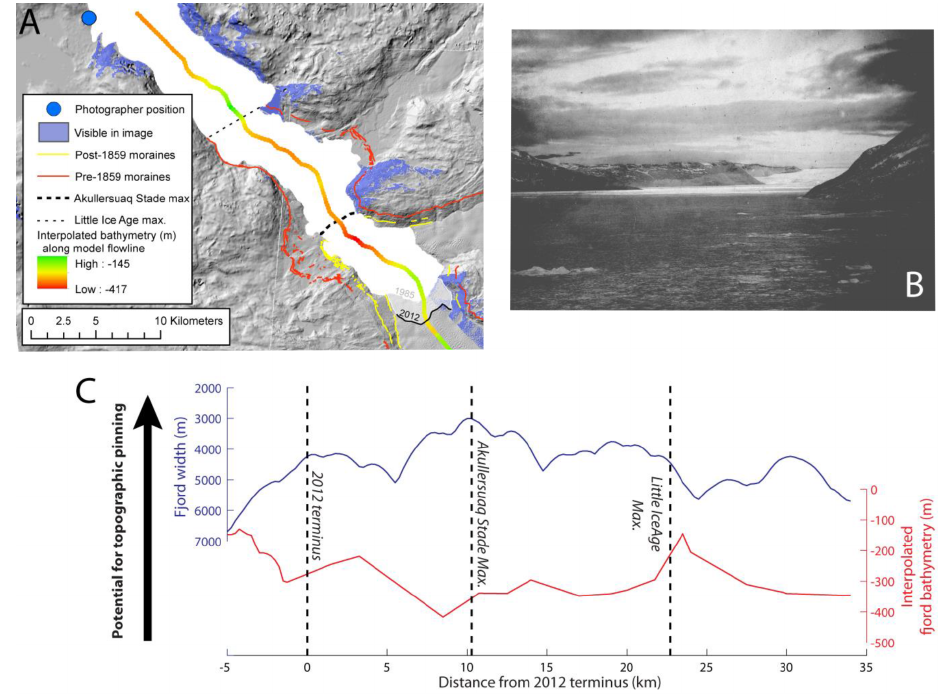
Figure 3. Viewshed analysis. (a) 1985 hillshaded DEM (see Fig. 1), with reconstructed photographer position showing areas that would be observable in the photograph, and the path of the model flow line showing the interpolated fjord bathymetry; (b) the photograph of KNS acquired in 1903; and (c) along-fjord width and depth relative to the 2012 terminus position. Note that fjord width is plotted on a reversed axis to reflect the relative potential for the occurrence of topographic pinning